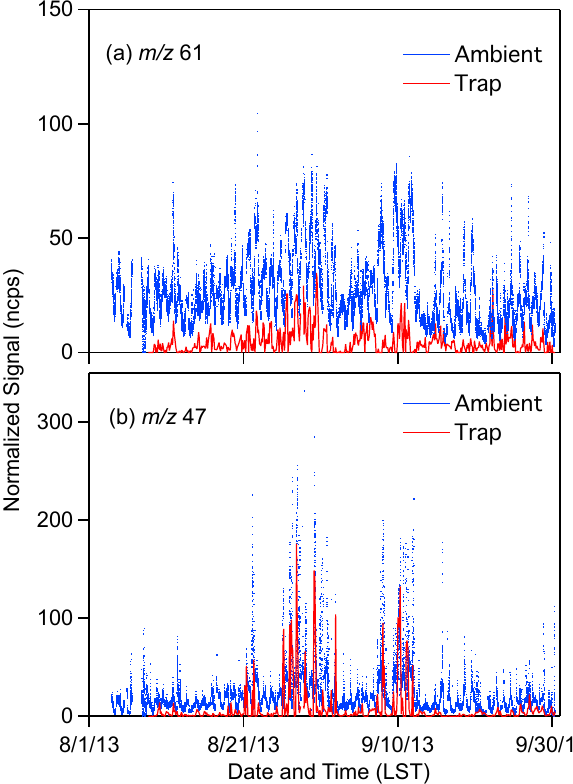
Figure 11. Ambient measurements of (a) m/z 61 and (b) m/z 47 during the SLAQRS campaign in East St. Louis, USA. Also shown are the acid trap measurements at the same m/z values, correspond- ing to the sum of non-acid isobaric